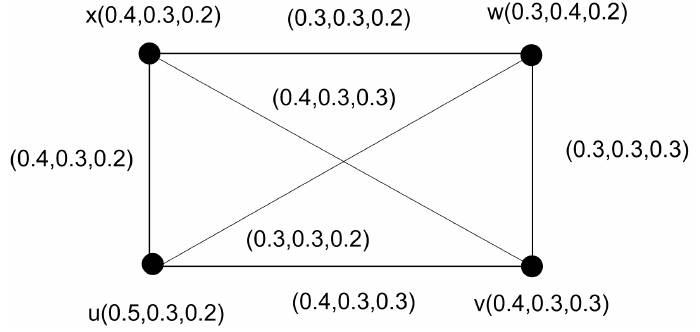
Figure 3. A complete picture fuzzy